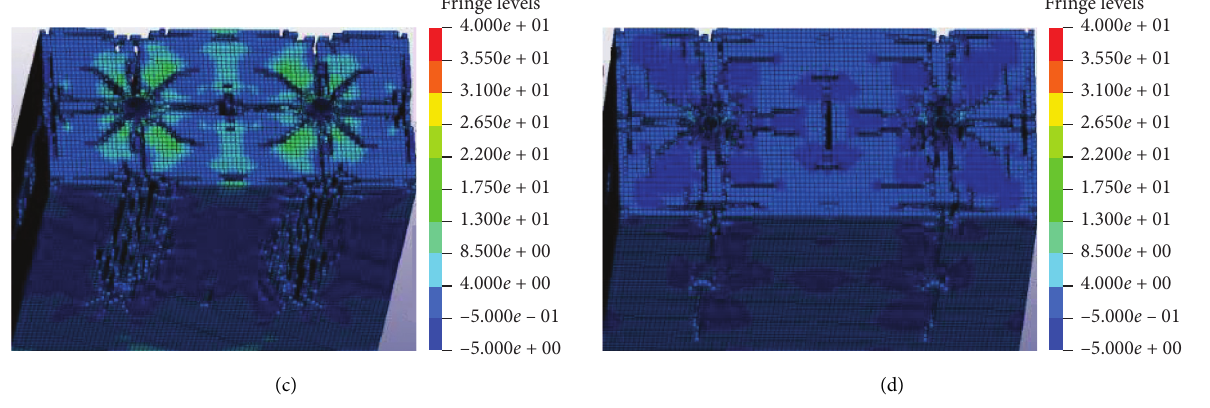
Figure 10: Simulation results of beams with different hole spacing when the aperture is 30 mm. (a) S � 200 mm. (b) S � 300 mm. (c) S � 400 mm. (d) S � 500